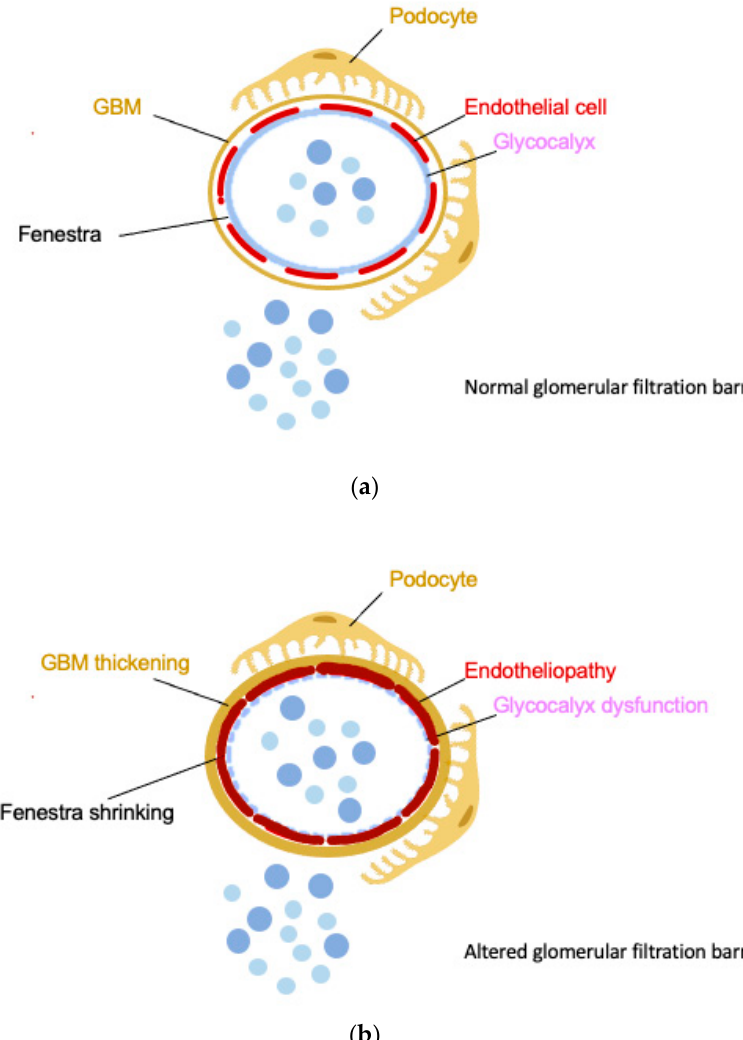
Figure 2. Schematic view of structural changes of the altered glomerular filtration barrier seen in shrunken pore syndrome. ( a ) The normal glomerular filtration barrier that consists of glomerular basement membrane (GBM), podocytes, endothelial cells, and endothelial glycocalyx. ( b ) Glomerular basement membrane thickening, fenestra shrinking, diminished glycocalyx function, and endotheliopathy are the structural hallmarks of altered glomerular filtration barrier, e.g., shrunken pore syndrome. The amount of large and low molecular weight solutes in the tubuli is the same both in ( a ) and ( b ), whilst the clearance of middle ‐ sized solutes (depicted as 5 bigger blue circles intraglomerular) is altered in shrunken pore syndrome ( b ) as compared to normal filtration ( a ) (3 bigger blue circles intraglomerular).